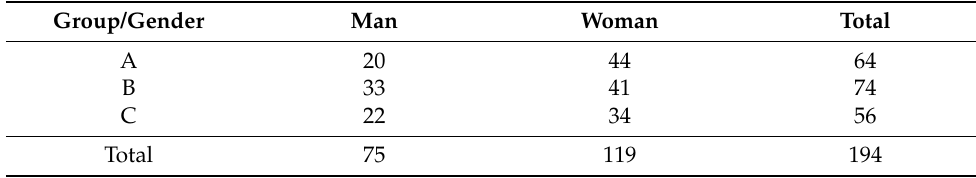
Table 2. Distribution of participants according to group and gender. Group/Gender